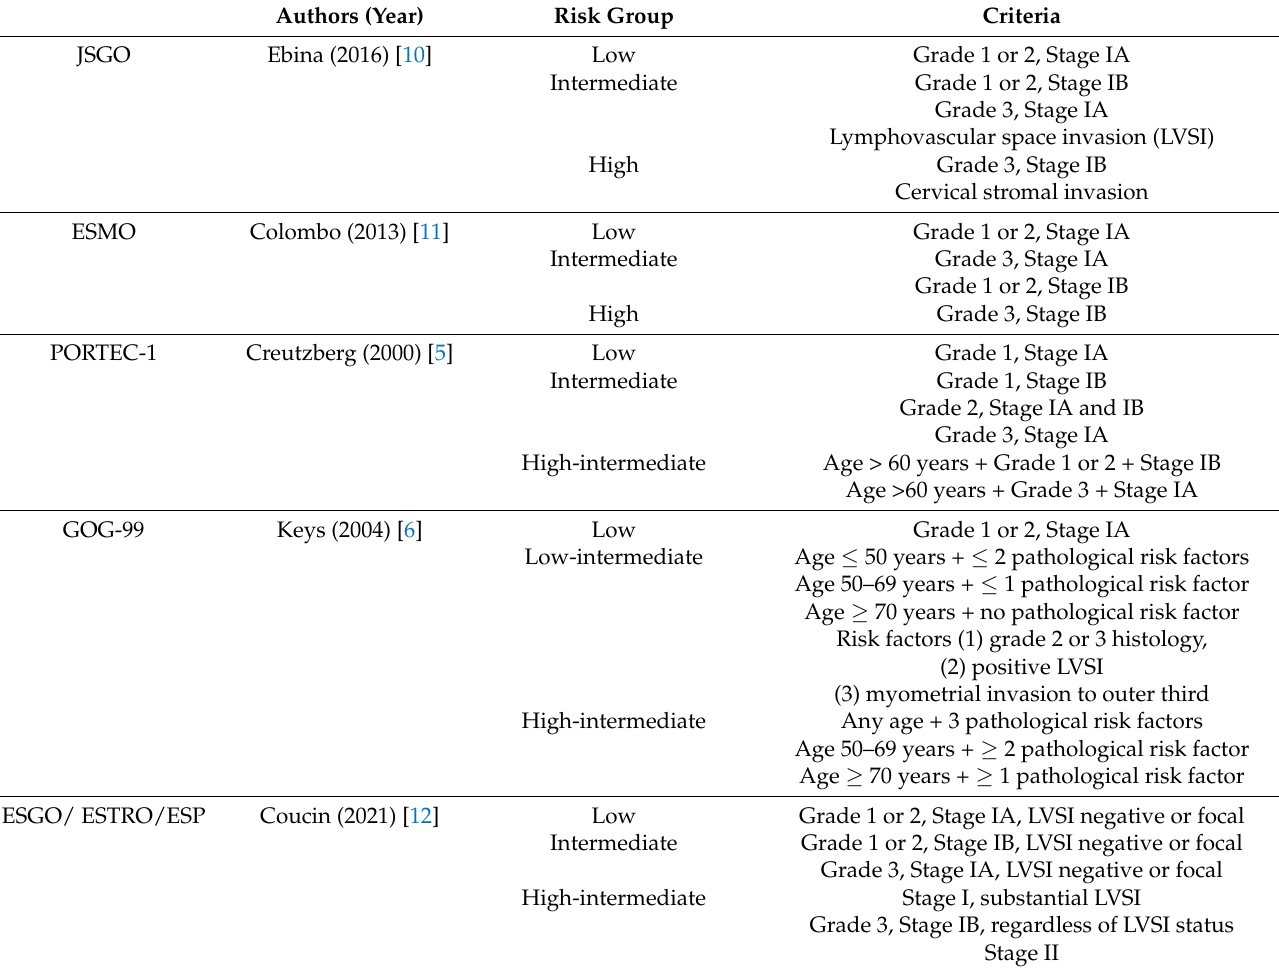
Table 1. Low-, intermediate-, high-intermediate, and high-risk endometrioid endometrial carcinoma without extrauterine